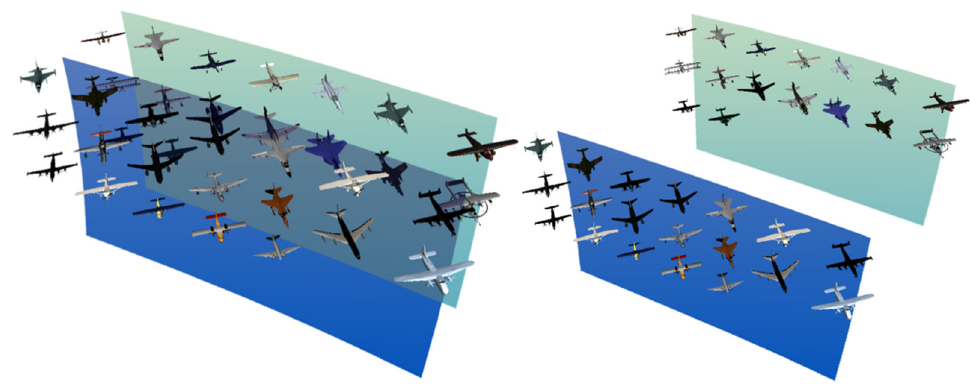
Figure 18. Depth distance experiment diagram of the relative position.